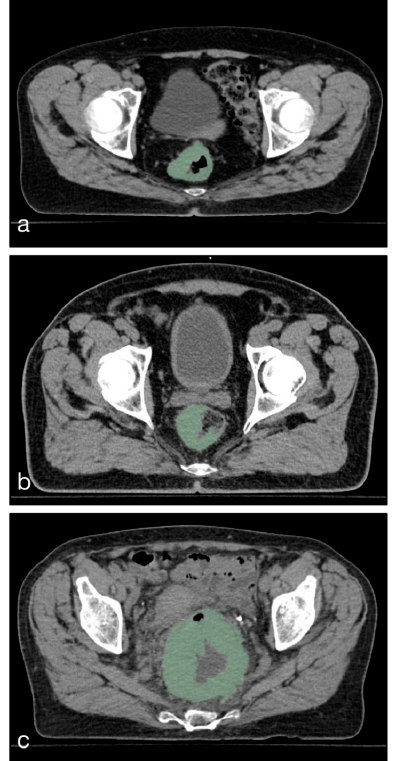
Figure 2. Three sample cases taken from the study population to illustrate the segmentation strategy. The segmented volume is marked in green color. Care was taken to only include tumor tissue ( a ) and exclude intraluminal contents ( b ), as well as surrounding tissue and gas inclusions ( c ).